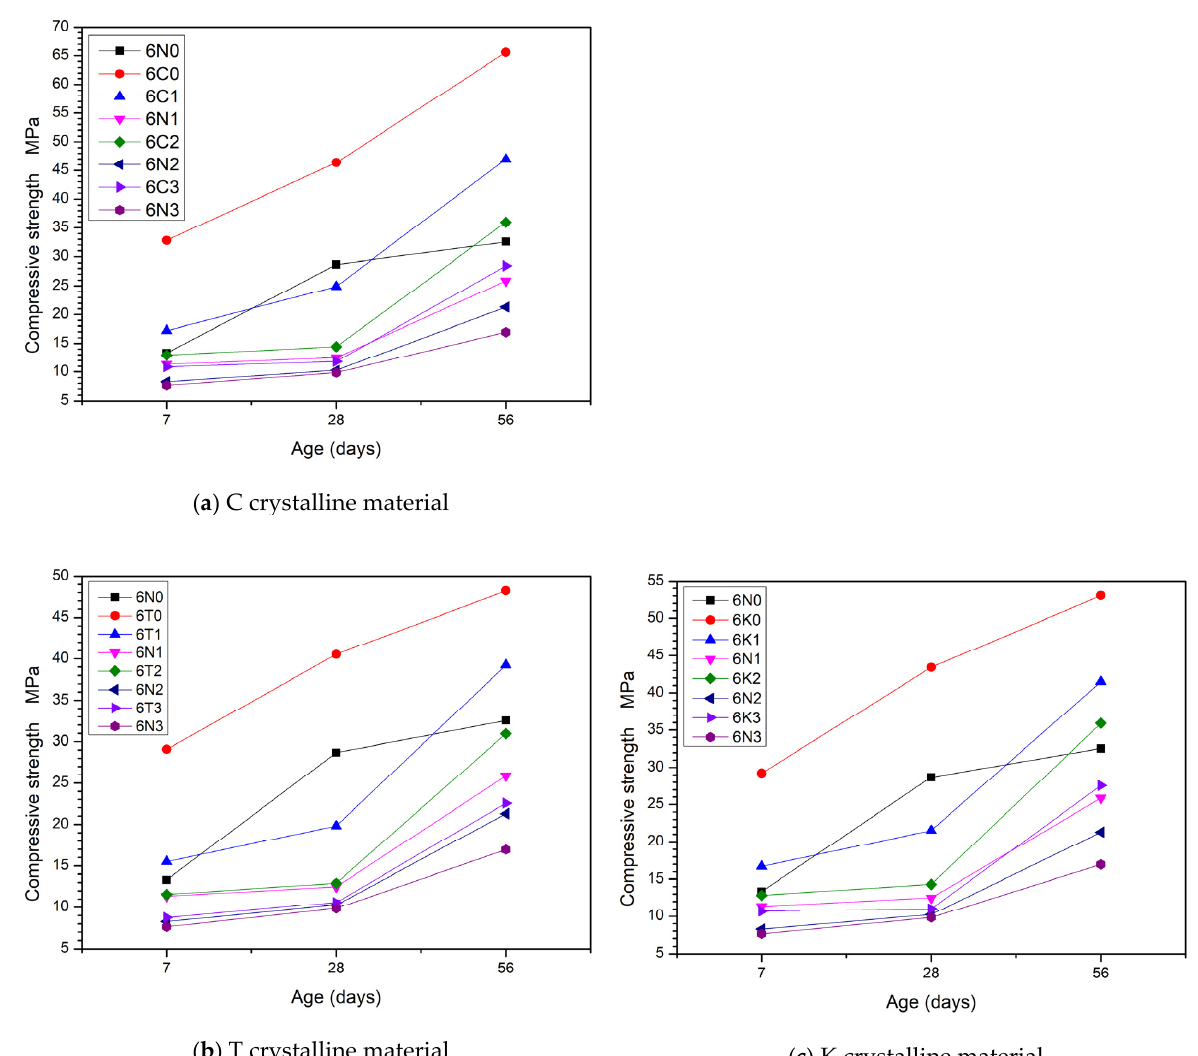
Figure 3. Compressive strength of cement mortar when W/C = 0.6.